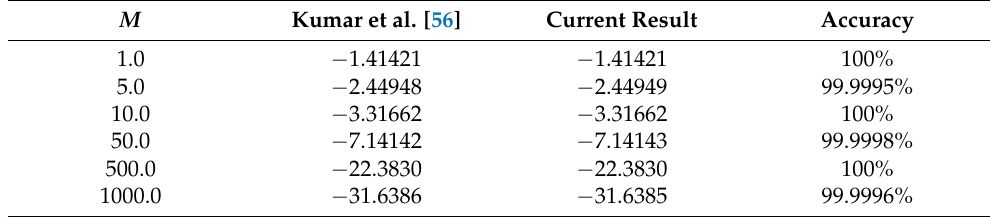
Table 3. Comparison of numerical values for f (cid:48)(cid:48) ( 0 ) for dissimilar values of M when α = 0 and R b = β = N = Λ =